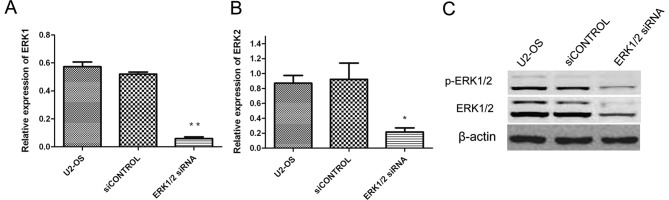
Specific downregulation of ERK1/2 mRNA and protein expression by ERK1/2 siRNA. Cells were transfected with 100 nM ERK1/2 siRNA or scramble siRNA (siCONTROL) for 48 h, and the relative mRNA levels of ERK1 and ERK2 were quantified by real-time PCR analysis (A and B) and the relative protein levels of ERK1/2 and phosphorylated ERK1 and ERK2 (pERK1/2) were determined by Western blotting (C). Data were normalized by using β-actin as an internal standard. *P<0.05 and **P<0.01 vs. siCONTROL.